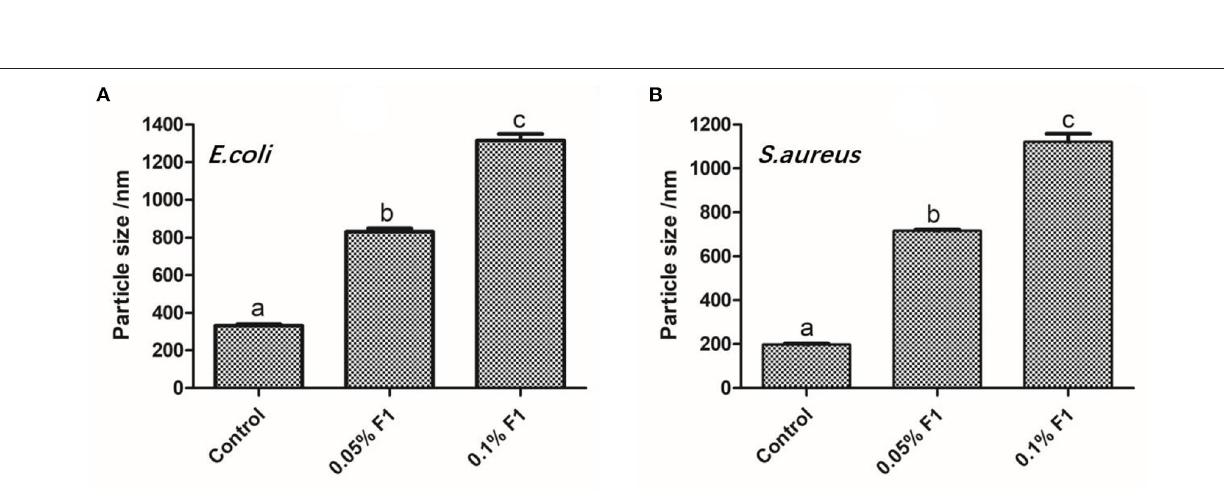
120 min. Our results also indicated that the antibacterial peptide F1 had a stronger effect on both bacteria in the first 150 min than the membrane breaker Triton X-100. After 150 min, the ion leakage concentrations of the antimicrobial peptide F1